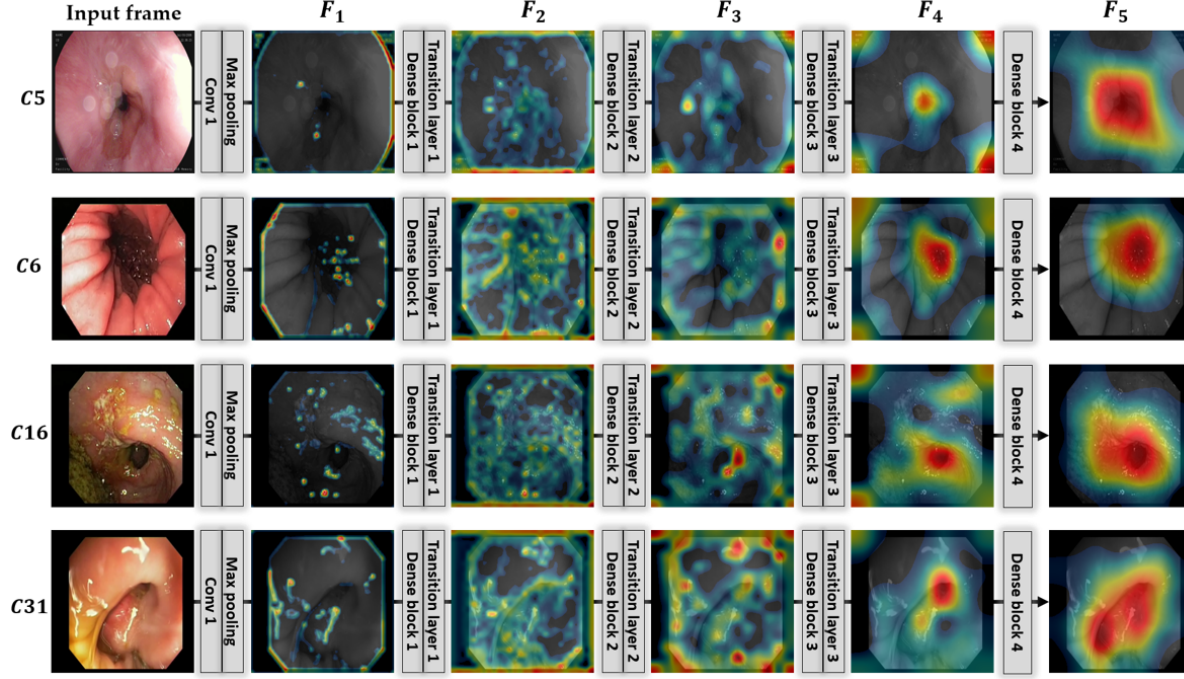
Figure 6. Obtained class-specific discriminative regions from different parts of the first-stage network (DenseNet) for given input